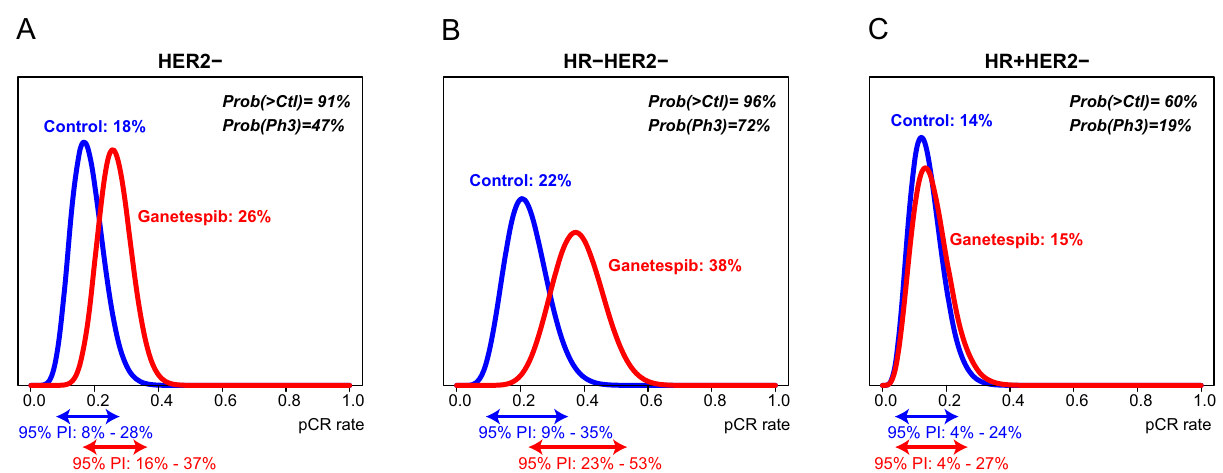
Fig. 2 Estimated rate pf pCR with ganetespib versus the concurrent HER2-negative control. Final pCR probability distributions in ganetespib (red) and control (blue) arms, for A All HER2-negative participants, B HR-negative/HER2-negative participants, and C HR-positive/ HER2-negative participants.